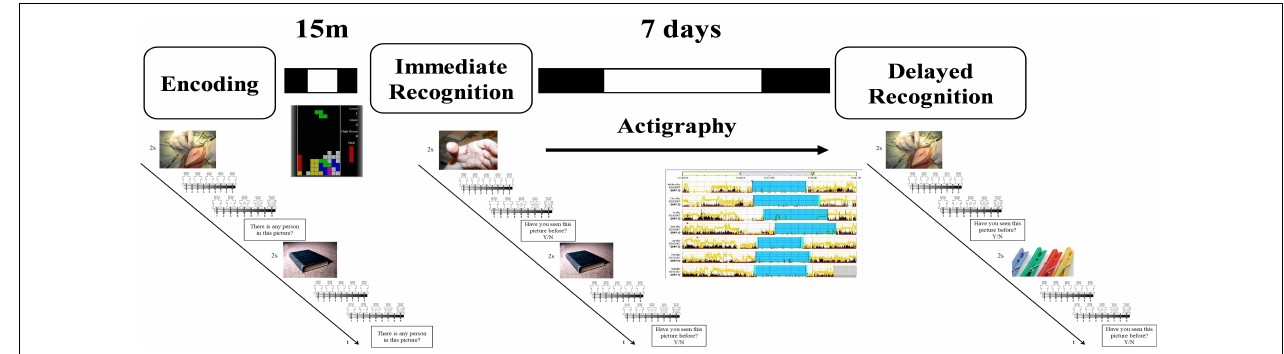
FIGURE 1 | Schematic representation of the experimental procedure. During the encoding session, participants were exposed to 40 neutral (objects, neutral faces) and 40 negative (injuries, attacking humans, and animals) pictures. They were asked whether a person was present in the picture or not. After each picture they rated how they felt in term of valence and arousal. After the task they played Tetris for 15 min before performing an immediate recognition session. During the immediate (15 min later) and the delayed (7 days later) recognition task, half of the pictures previously presented were randomly rearranged and intermixed with 40 new pictures similar in term of content, and normative valence and arousal ratings. Participants had to decide whether they had seen or not the picture in the previous session. Between the immediate and the delayed recognition sessions participants wore an actigraph and complete a daily sleep log.